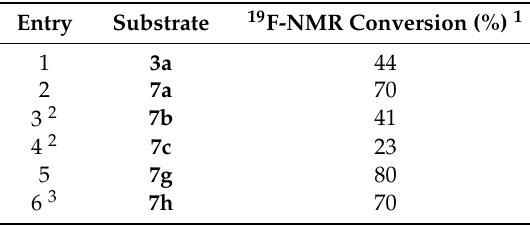
Table 2. α -Trifluoromethylselenolation of ketones performed under flow conditions.